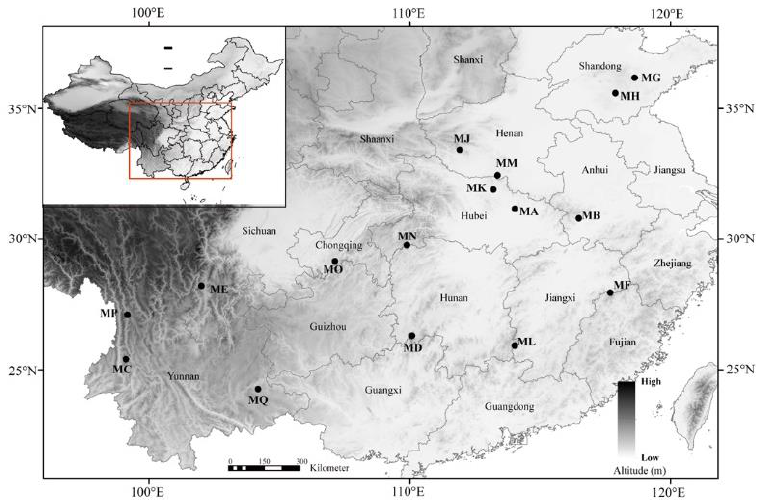
Figure 4. Locations of the 16 populations of P. persica sampled for this study. Cool to warm colors represent low to high altitude.